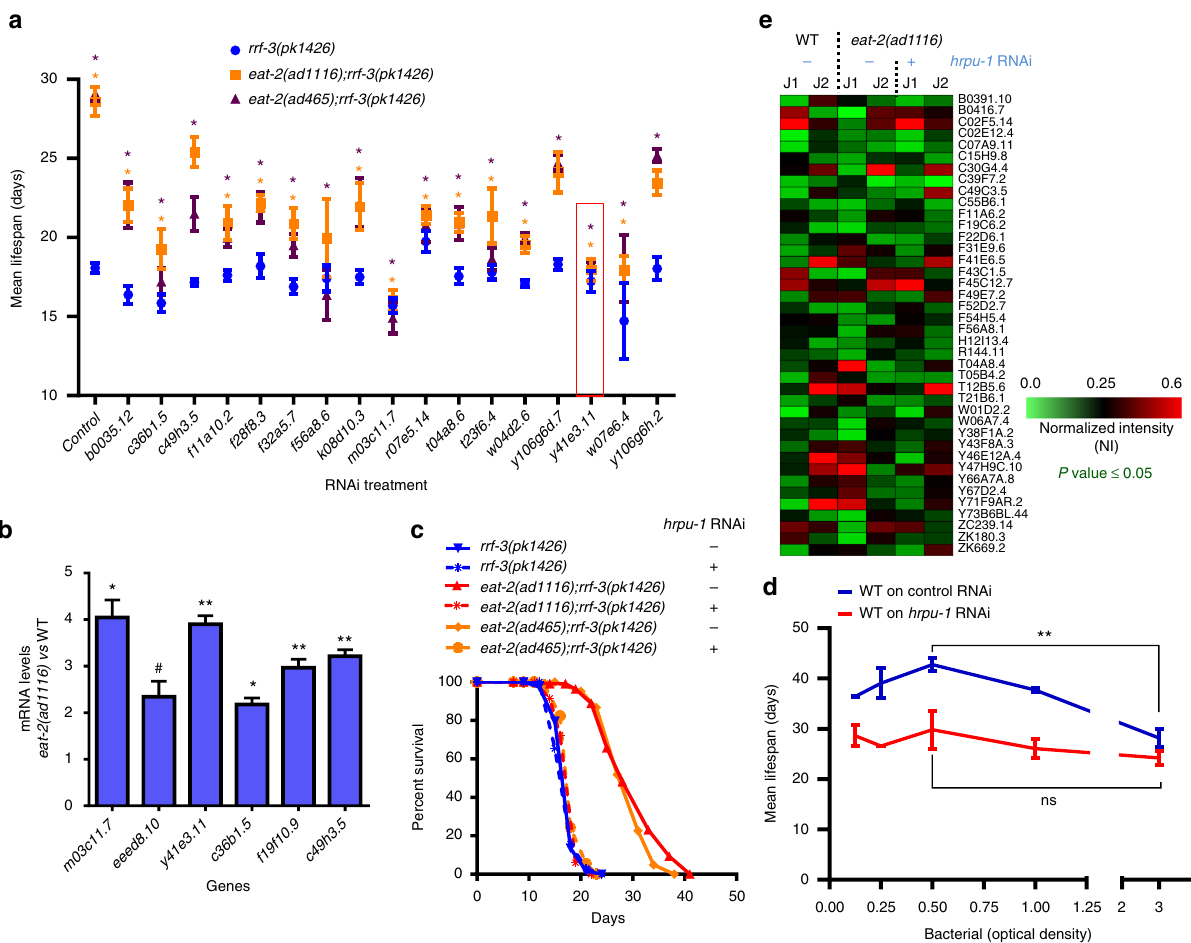
Fig. 3 Splicing mediators are required for DR-mediated lifespan extension. a Speci fi c requirement of splicing mediators in DR-mediated lifespan extension. Mean lifespans of eat-2(ad1116);rrf-3(pk1426) or eat-2(ad465);rrf-3(pk1426) when splicing factor genes were knocked down by RNAi. The rrf-3(pk1426) background makes eat-2 mutants hypersensitive to RNAi. Averages of two or more biological replicates are shown. P values determined by unpaired two-tailed t- test between the control and gene-of-interest RNAi for each individual strain. Asterisk (*) indicates signi fi cant differences with P ≤ 0.05; orange asterisk is for eat-2(ad1116);rrf-3(pk1426) , purple asterisk is for eat-2(ad465);rrf-3(pk1426) ; lifespan suppression in rrf-3(pk1426) was not signi fi cant in all cases. Asterisk in case of control RNAi shows that the lifespan of eat-2(ad1116);rrf-3(pk1426) or eat-2(ad465);rrf-3(pk1426) is signi fi cantly different from rrf-3(pk1426) . Lifespan data provided in Supplementary Table 2. Experiments were repeated at least three times. Red box indicates y41e3.11 gene that we followed further. b qRT-PCR to detect upregulation of splicing mediator genes in eat-2(ad1116) . Expression levels were normalized to actin and compared to WT. Average of two biological replicates. Asterisks indicate statistically signi fi cant differences to the corresponding WT samples as calculated by unpaired two-tailed t -test (* P ≤ 0.05; ** P < 0.01, # P = 0.0556). c Representative lifespans (one of three or more) of eat-2(ad1116) and eat-2(ad465) when grown on y41e3.11 ( hrpu-1 ) RNAi (indicated by +) from L4 onwards. Control (vector) RNAi indicated by negative ( − ). Lifespan data are provided in Supplementary Table 2. d A bDR assay using WT grown on control or hrpu-1 RNAi. Control RNAi-grown worms produced a bell-shaped graph , while the ones grown on hrpu-1 failed to do so. An average of two biological replicates is shown. Bacterial culture of OD 600 = 3.0 was the starting concentration for serial dilution. Additionally, the increase in lifespan when WT on control RNAi were maintained at OD 600 = 0.5 was signi fi cant as compared to OD 600 = Supplemental Table 3. e Reversal of differential alternative splicing pattern of eat-2(ad1116) upon knockdown of hrpu-1 by RNAi. J1 and J2 indicate two junctions of the same gene showing the highest signi fi cant differences in their splicing indices. Four biological replicates were used for RNA-seq. Statistical analysis was performed on NI using two-tailed unpaired t- test with Sidak – Bonferroni correction for individual event. ( Error bars =